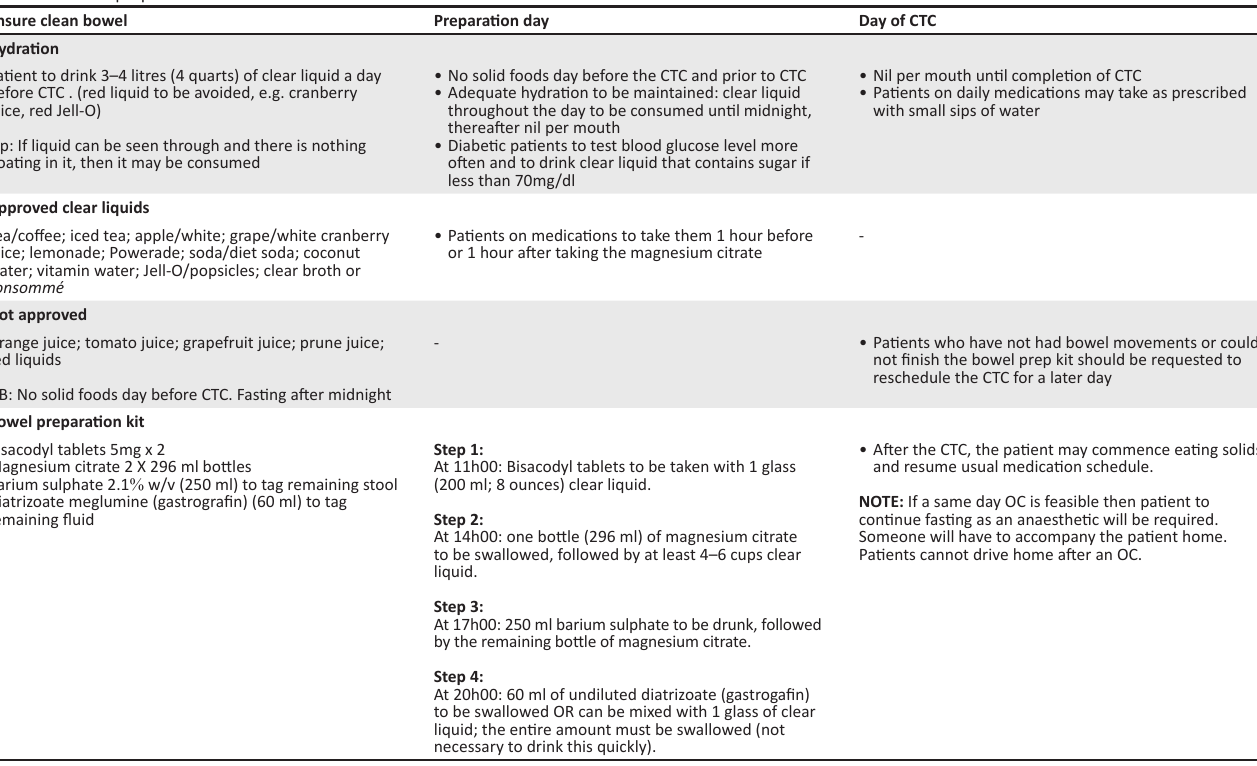
TABLE 3: Patient preparation. Ensure clean bowel Preparation day Hydration